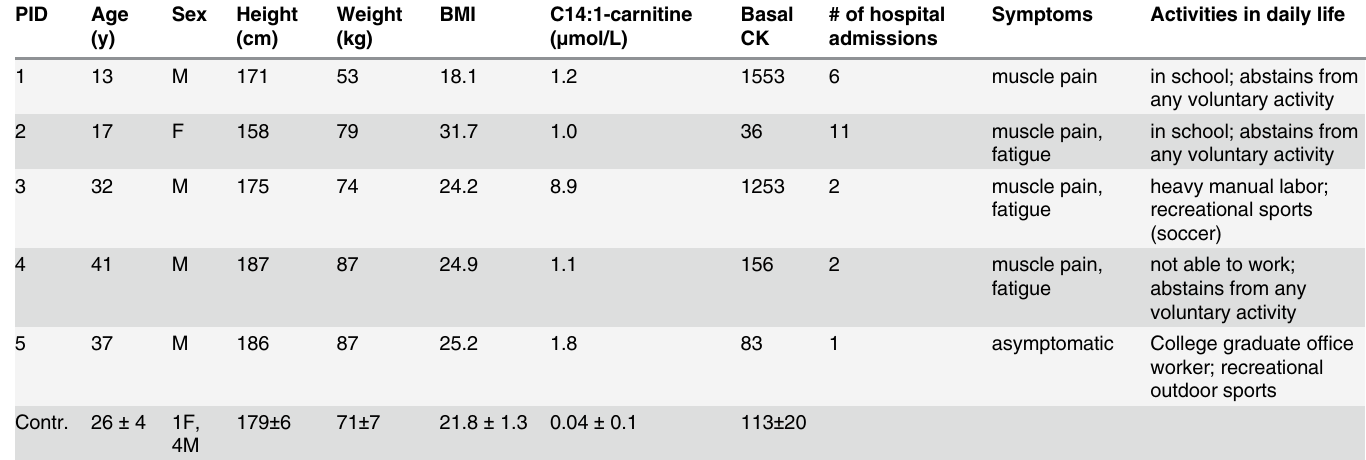
Table 1. Patient characteristics and plasma concentration of several metabolites in resting conditions. PID = Patient Identification number; y = year; M = male/F = female; BMI = body mass index; CK = creatine kinase. Contr. = controls Mean ± SEM is reported.